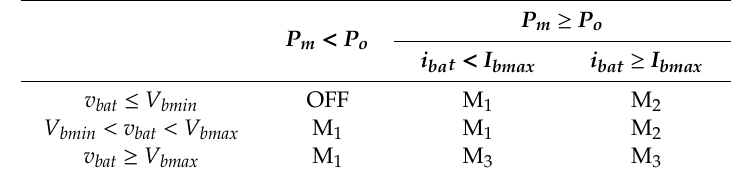
Table 1. The multiple operating modes of PVDCM.